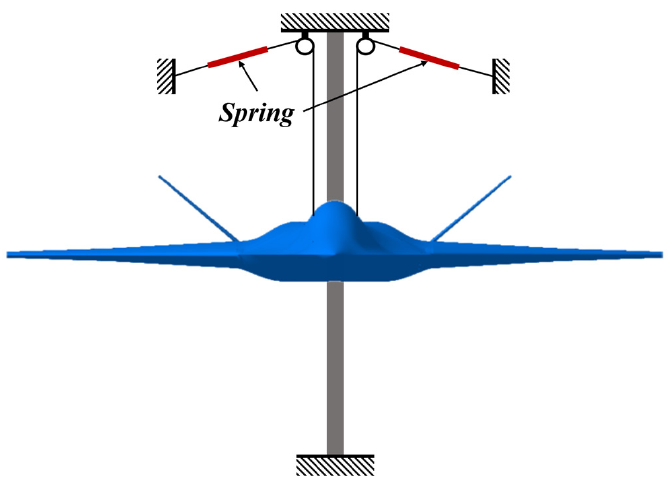
Figure 23. Auxiliary springs for suspending the present